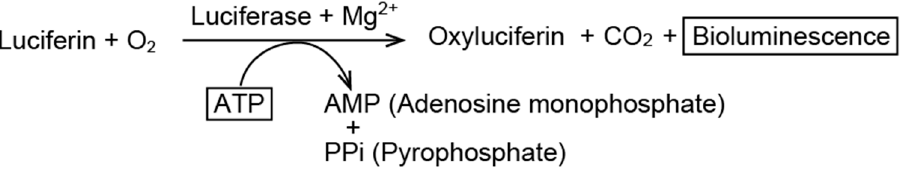
Figure 1. Schematic of luciferin–luciferase reaction for ATP quantification.